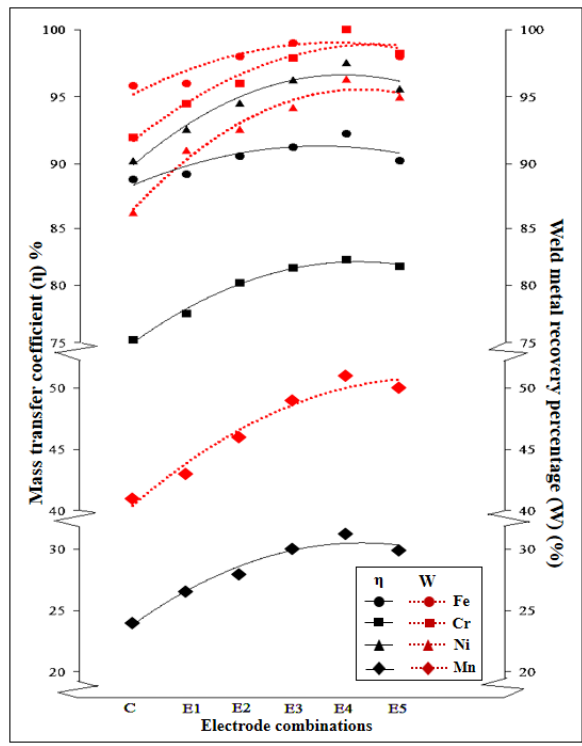
Figure 3: Mass transfer coeflcient and weld metal recovery